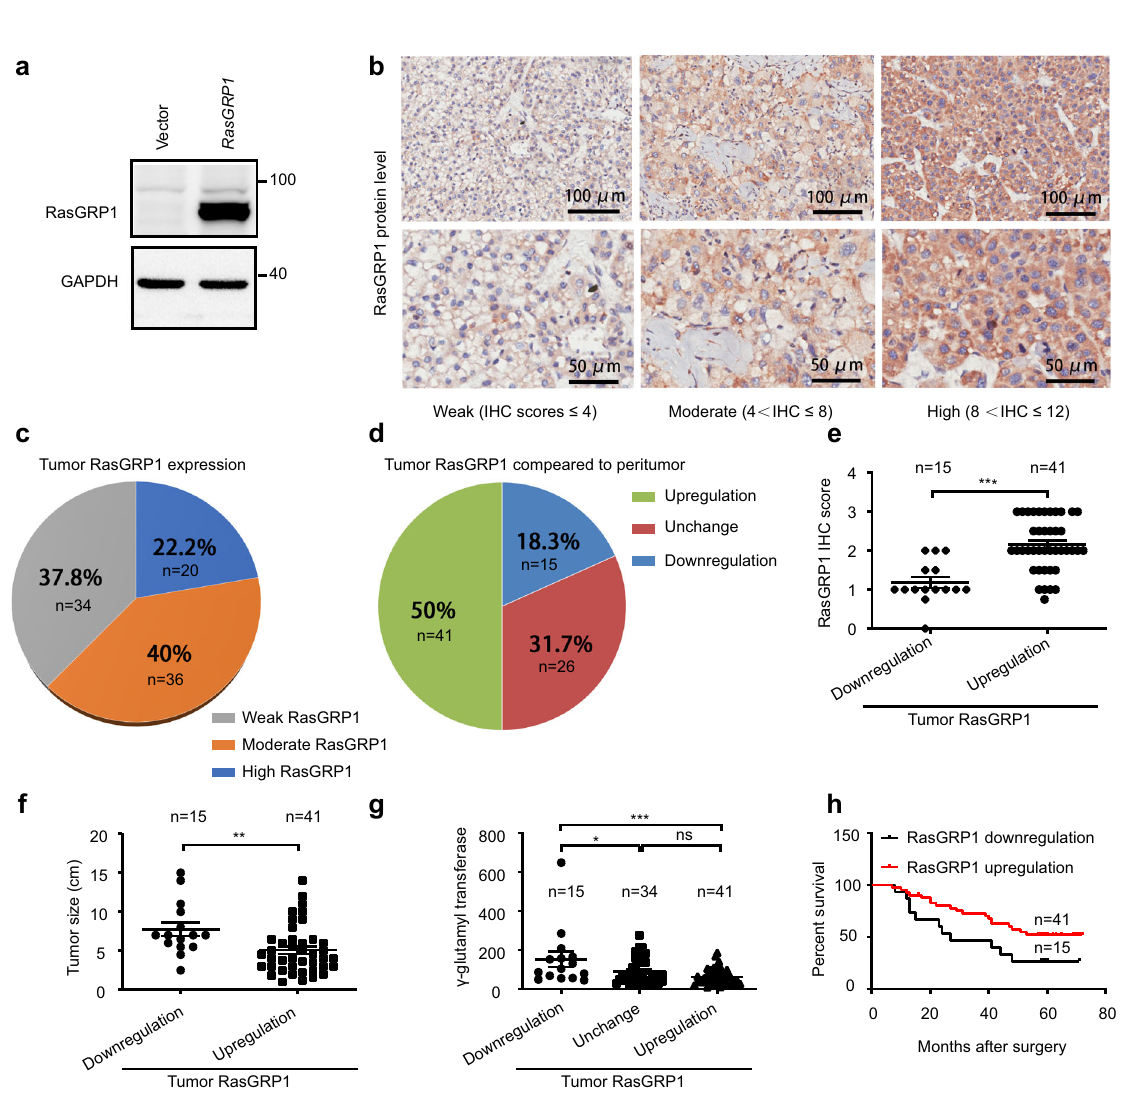
Fig. 7 | RasGRP1 affects the prognosis of liver cancer patients. a Western blot analysis with speci fi c anti-RasGRP1 antibodies (the image shown in a is a repre- sentative of three independent experiments. b Representative images showing immunohistochemistry (IHC) staining (Primary antibody: anti-RasGRP1, 1:100 dilution, Abcam, ab37927; Second antibody: HRP-labelled goat anti-rabbit IgG, 1:1000 dilution, Sigma-Aldrich, AP132P) indicating high, moderate and weak staining intensity of RasGRP1 protein in a human liver cancer tissue microarray. c Pie chart showing the IHC-determined RasGRP1 expression levels in tumour tis- sues according to the fi ndings shown in ( b ). d Demographics of the liver cancer patientsexhibitingRasGRP1expressionchangesintumourtissuescomparedthose